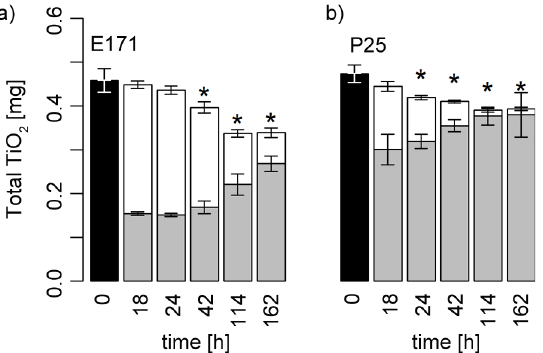
Fig 1. Total TiO 2 suspended or sedimented in the hydroponic system. Red clover was exposed (n = 3) over 162 h to the two nanoparticles P25 and E171. TiO 2 amounts of the pooled stock suspension is shown at t = 0 in black. TiO 2 amounts of the top (white, 17 ml, in contact with roots) and bottom part (grey, 3 ml, including precipitate) are shown. Differences of the total TiO 2 NP amount (bottom and top part together) to the total Ti amount at t = 0 are indicated with asterisks (p < 0.05). Error bars indicate standard deviations (n =